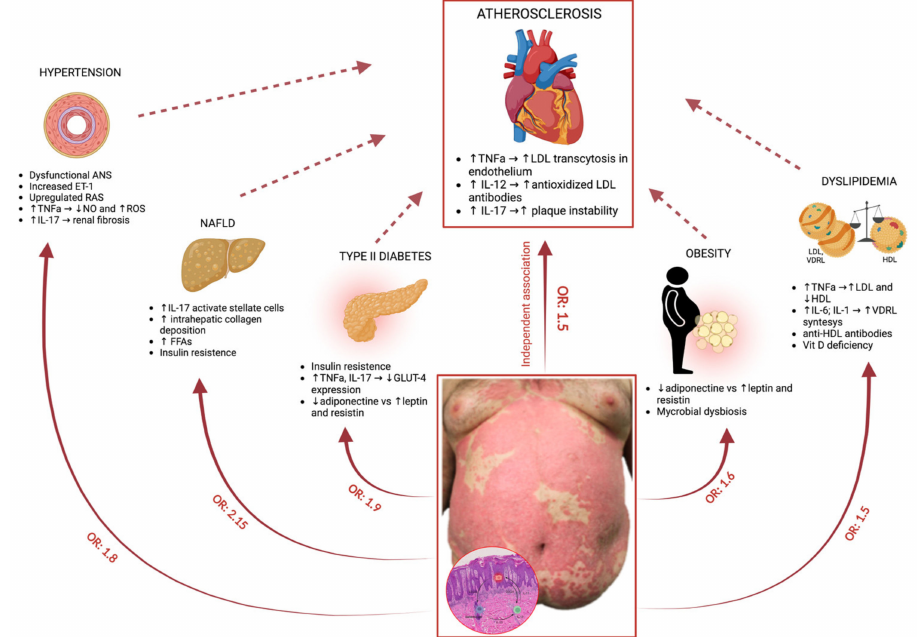
Figure 1. Molecular pathways involved in the link between psoriasis and its comorbidities. Psoriasis per se is considered an independent risk factor for atherosclerosis. Moreover, psoriasis is also associ- ated with a high prevalence of traditional modifiable CV risk factors, such as hypertension, diabetes, hyperlipidemia, obesity, and nonalcoholic fatty liver disease (NAFLD) [27–29]. Aberrantly activated molecular pathways involved in the link between psoriasis and its comorbidities are